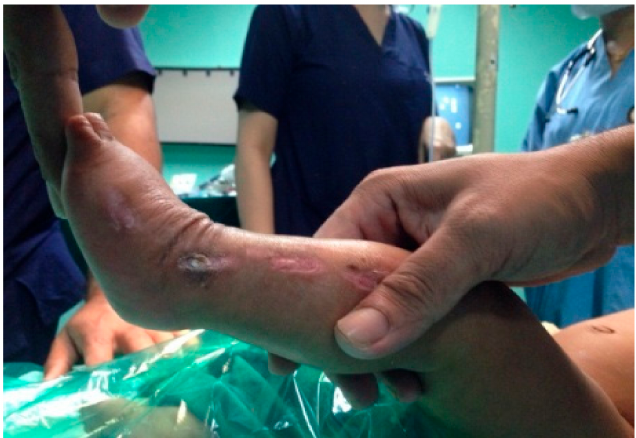
Figure 2. Manipulation.